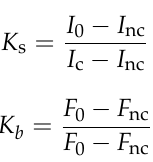
Figure 15. Stress distributions of specimen WPO. ( a ) Stress of reinforcement wire. ( b ) Stress of steel truss parallel to the span. ( c ) Stress of steel truss perpendicular to the span. ( d ) Stress of strengthened steel truss. The non-English term ‘ 平均 ’ means ‘Average’.